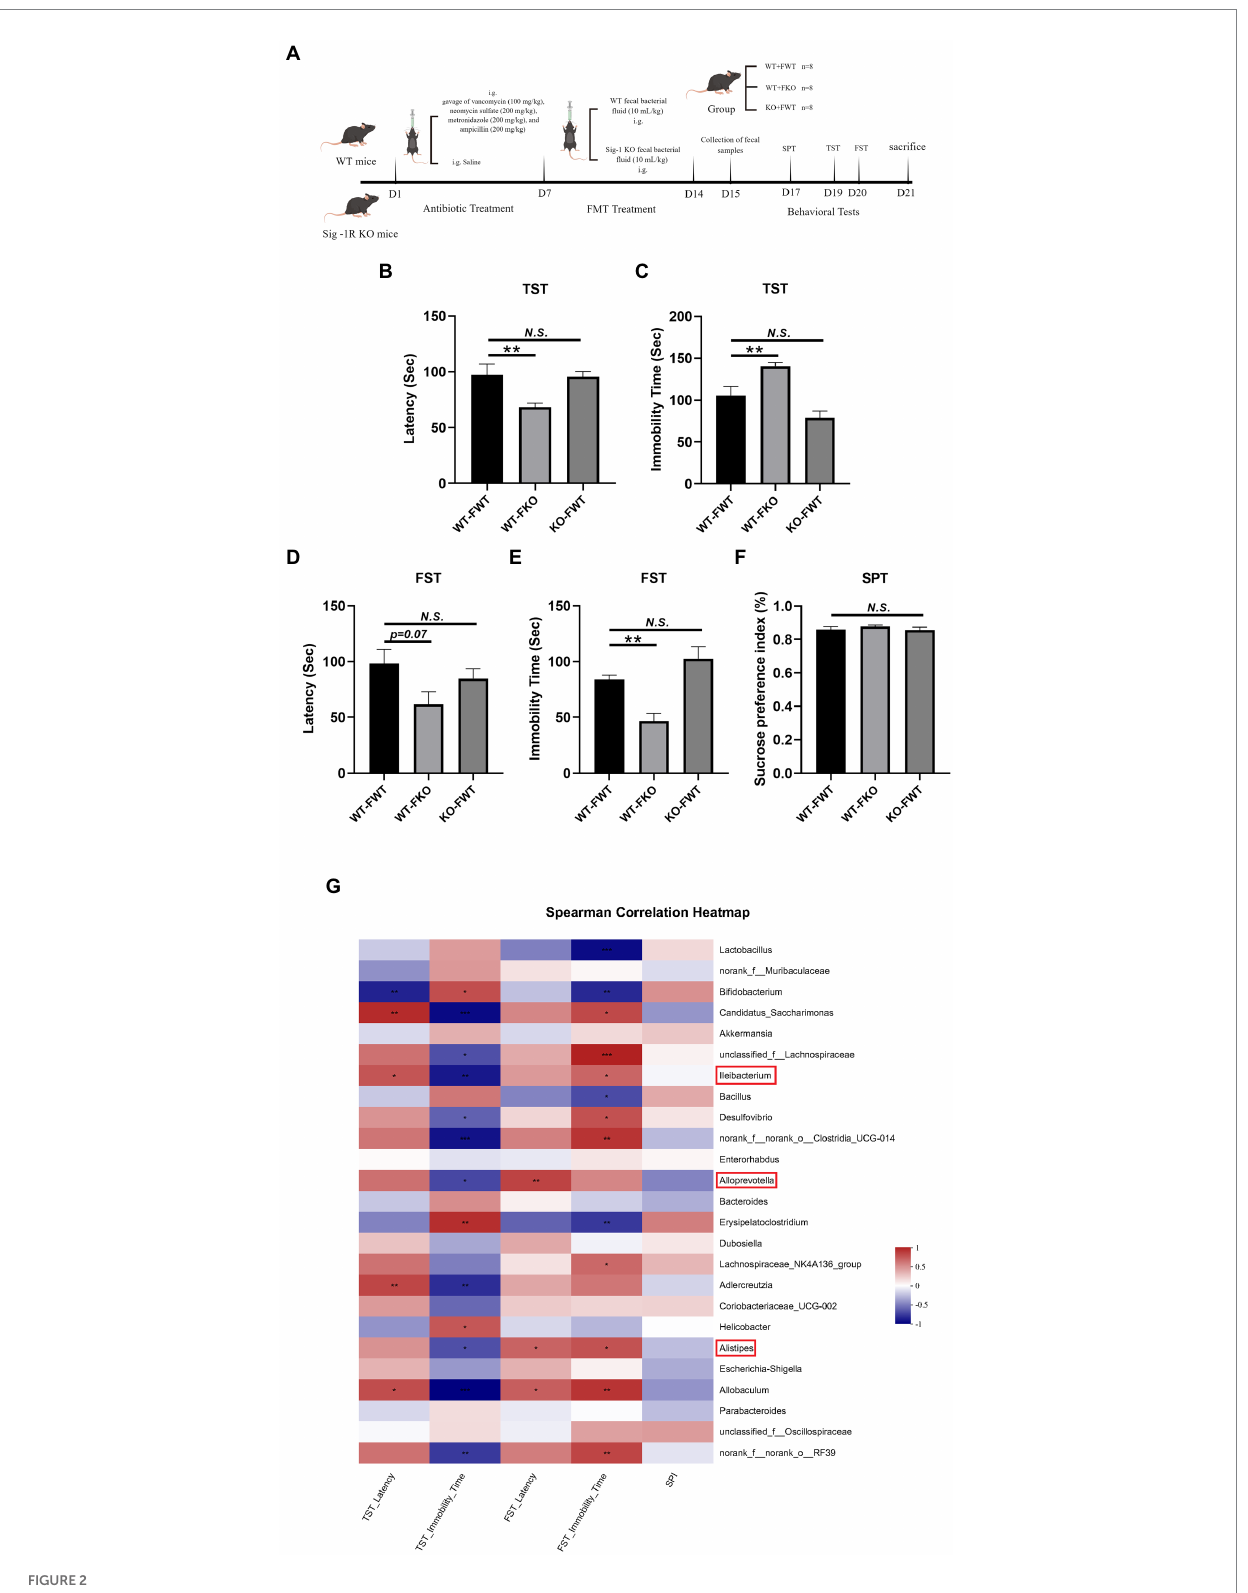
FIGURE 2 Sig-1R KO gut microbiota induced depression-like behaviors. (A) The FMT treatment flowchart. By Figdraw. (B) Latency (s) to immobility in the TST. F (2, 18) = 6.048, p = 0.0098. (C) Immobility time (s) in the TST. F (2, 18) = 14.20, p = 0.0002. (D) Latency (s) to immobility in the FST. F (2, 15) = 2.884, p = 0.0871. (E) Immobility time (s) in the FST. F (2, 15) = 13.60, p = 0.0004. (F) The sucrose preference index (SPI) in the SPT. F (2, 15) = 0.6173, p = 0.5523. ** p < 0.05. N.S. : not significant. WT-FWT, n = 7; WT-FKO, n = 7; and KO-FWT, n = 7. (G) The correlation between the gut microbiota and depressive-like behaviors in recipient mice was analyzed using Spearman’s correlation analysis. The red color represents a positive correlation; the blue color represents a negative correlation. Asterisk-marked columns indicated significant correlation. *0.01 < p ≤ 0.05 ， **0.001 < p ≤ 0.01, and *** p ≤